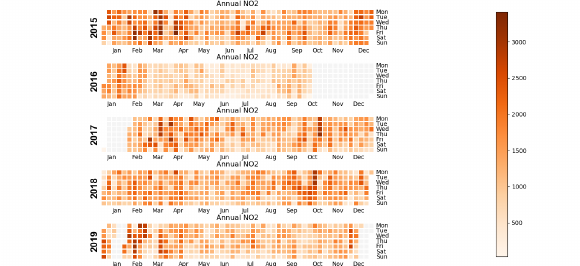
Figure 2: Annual NO 2 data value per day over the years (2015 to 2019).